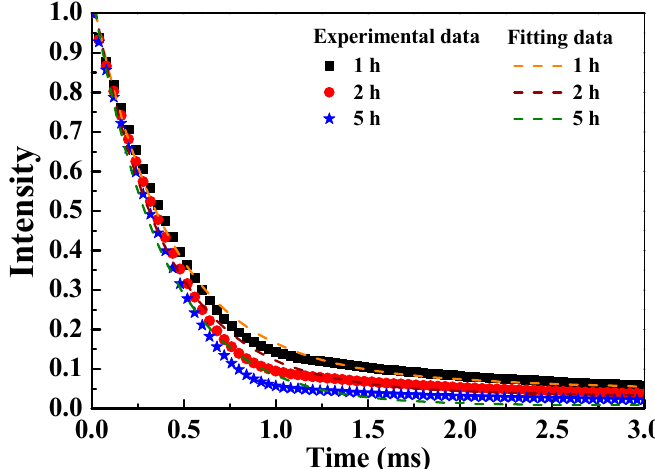
Figure 7. Decay times of the [Sr 0.99 Eu 0.01 ] 3 MgSi 2 O 8 phosphors sintered for different durations.